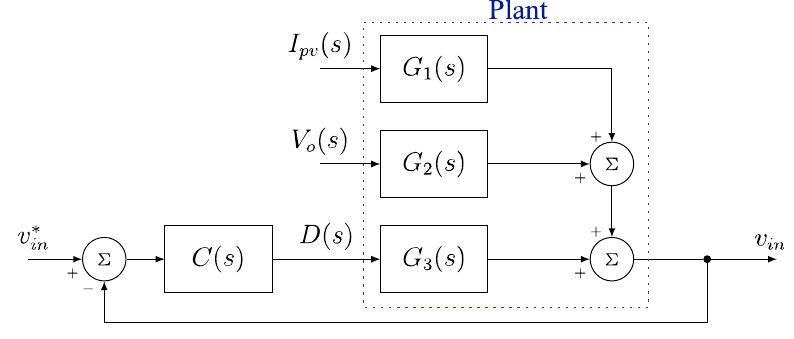
Figure 5. Block diagram of the input voltage control